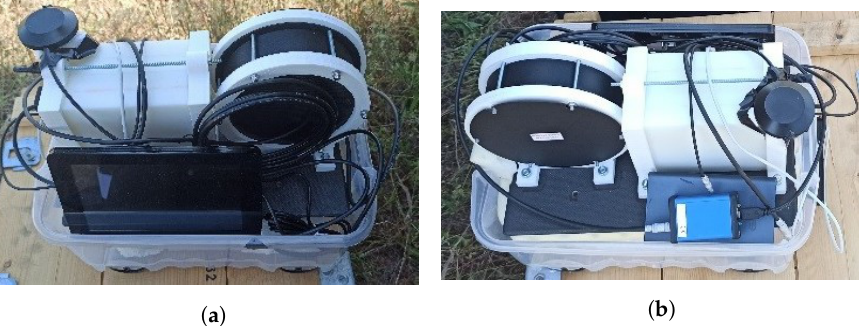
Figure 4. Handheld configuration of the radiation detection system: ( a ) Back side. ( b ) Front